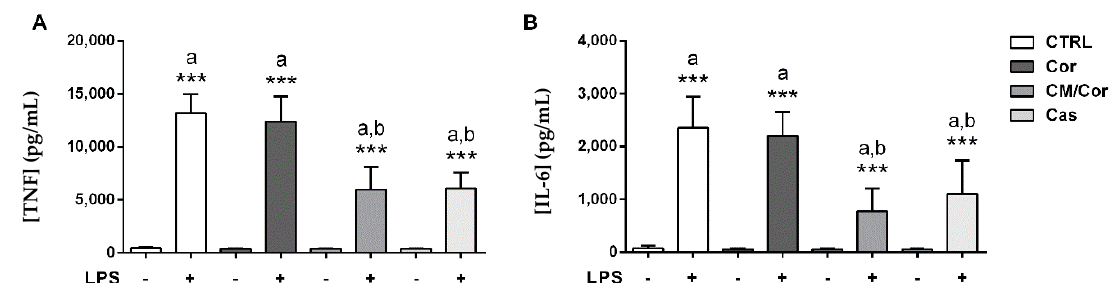
Figure 2. EVOO extracts differently modulate proinflammatory cytokine secretion in BMDCs from wild-type mice based on their chemical composition. Production of cytokines from untreated (Ctrl) and treated BMDCs with different EVOO extracts (12.5 µ g/mL) was determined at basal conditions and 24 h after LPS stimulation by ELISA. The bars represent mean values of TNF ( A ) and IL-6 ( B ) ± SEM ( n = 3). a: LPS stimulated vs. unstimulated samples; b: Cor-CM/Cor-Cas extract + LPS vs. Ctrl + LPS stimulated samples. *** p < 0.0001.